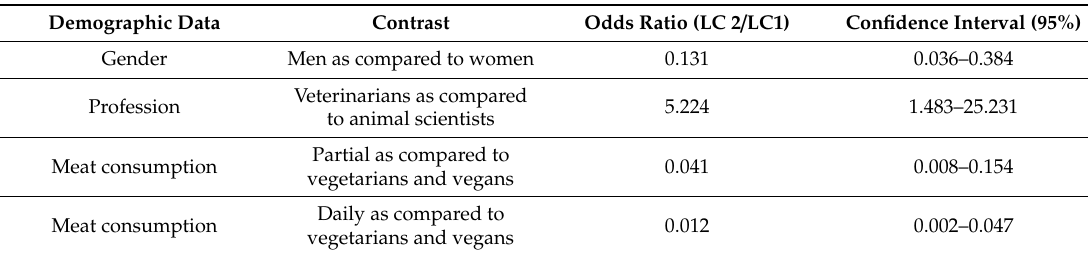
Table 1. Results of the logistic regression model for the chances produced by latent class (LC) analysis for the group of questions related to benefits and harms of conventional and cell-based meat, according to the responses to an online questionnaire by 209 Brazilian veterinarians and 63 animal scientists. LC 2 presents a more pro-cell-based perception.